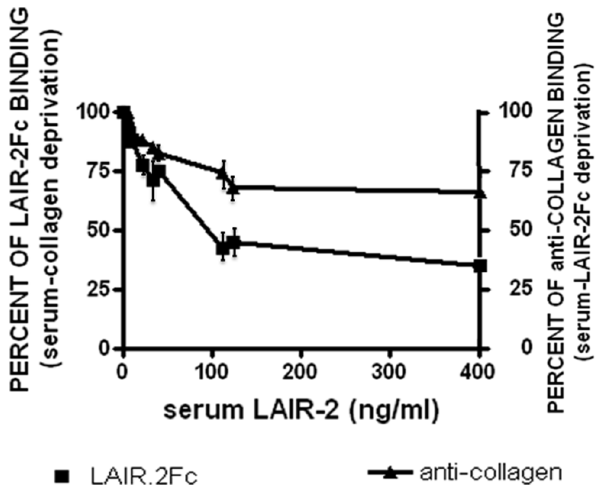
Figure 2. LAIR-2 found in serum of patients with ATD and healthy donors is able to recognize collagen as natural ligand. Pre-incubation of collagen solution with selected sera (4 HT; 4 GD; 4 MNTG) results in a decreasing of its ability to bind LAIR-2-Fc construct proportional to the sera LAIR-2 amounts. Similarly, pre-incubation of LAIR-2-Fc with sera shows a reduction of anti-collagen binding. Control wells were set up with the native (not pre-incubated) collagen solution or LAIR-2-Fc molecule (100% of binding). A representative experiment of three is shown. Bars represent standard deviation.